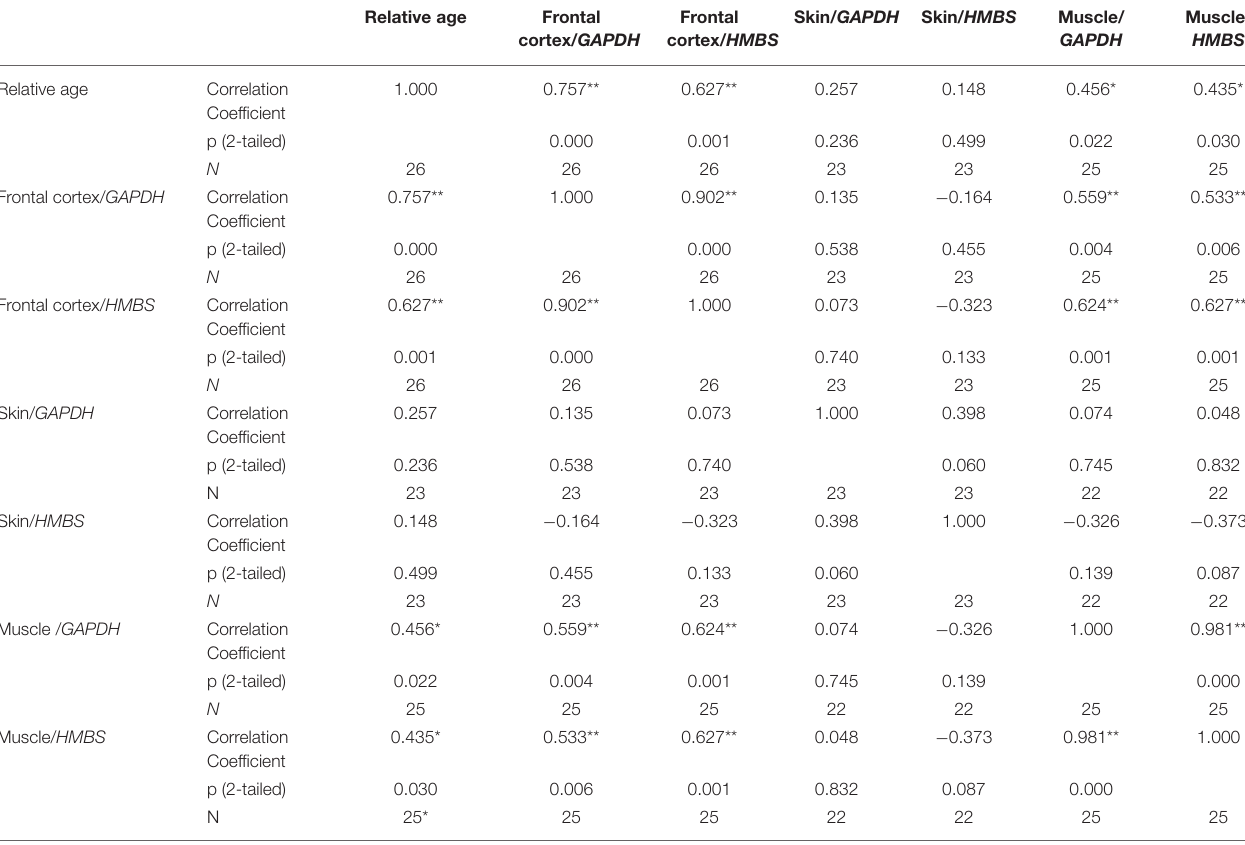
Relative age Frontal Frontal Skin/ GAPDH Skin/ HMBS Muscle/ cortex/ GAPDH cortex/ HMBS